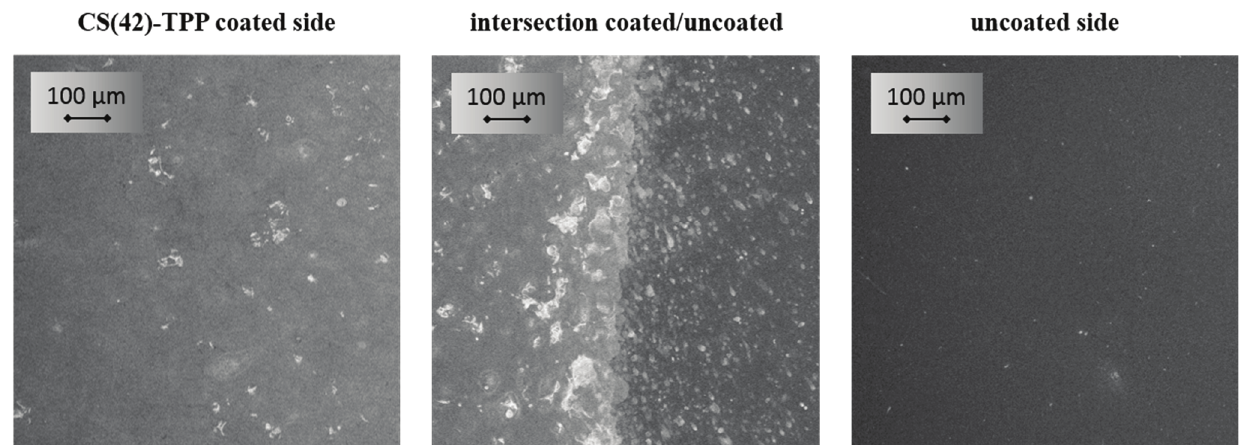
Figure 4. SEM pictures of spray-coated chitosan-tripolyphosphate nanoparticle solution films (3:1, 1 mg/mL, 0.075% AcOH, DA 42%) on a partially coated titanium substrate with a 250× magnification.